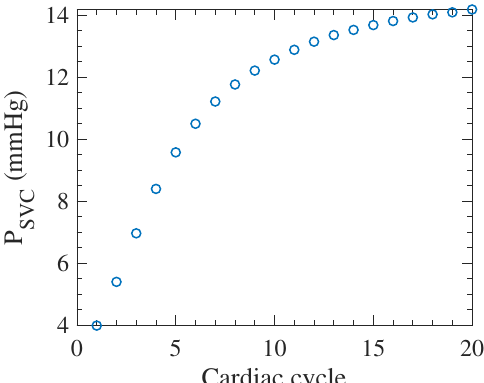
Figure 4. Mean SVC pressure over one cardiac cycle as the simulation progresses for 2.0 mm 2 nozzle area and 7.0 Wood units-m 2